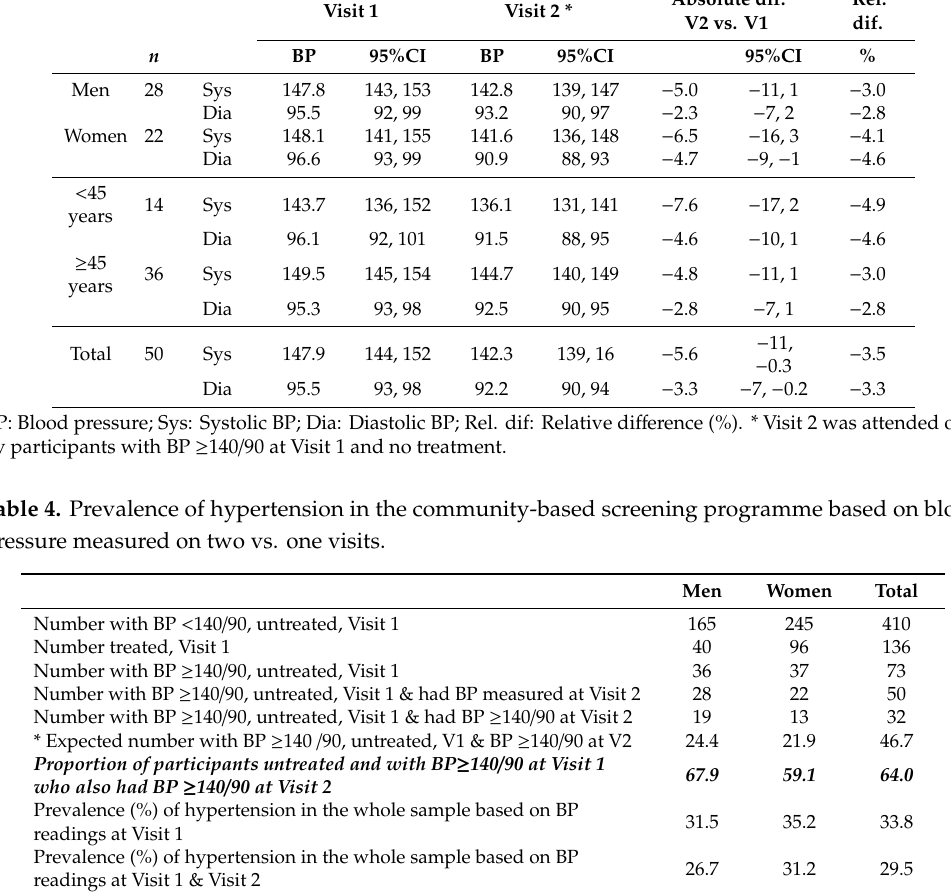
Table 3. Mean systolic / diastolic blood pressure on the first and second visits among participants to the community-based screening programme who were untreated and had elevated blood pressure at the first visit. Absolute dif. Rel. Visit 1 Visit 2 * V2 vs. V1 dif. n BP 95%CI BP 95%CI 95%CI % 28 Sys 147.8